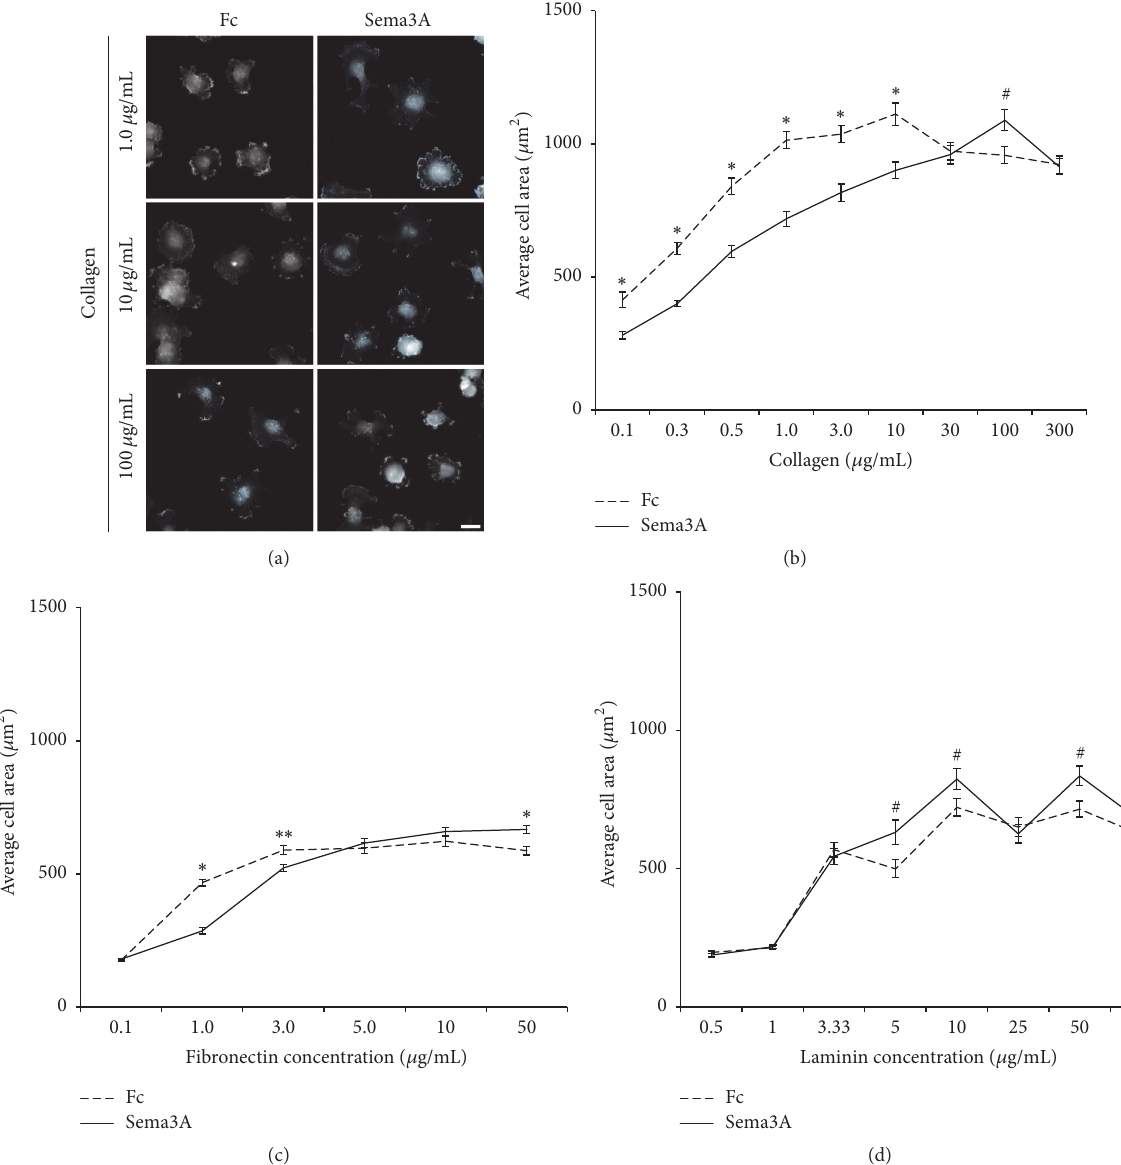
Figure 3: Sema3A increases cell spreading on low and intermediate coating concentrations of collagen and fibronectin but inhibits spreading athighcoatingconcentrationsofcollagenandfibronectin. (a)Representativeimagesofcellsattachedtosubstratacoatedwithlow(1.0 𝜇 g/mL), intermediate (10 𝜇 g/mL), and high (100 𝜇 g/mL) concentrations of collagen that were stained using TRITC-phalloidin. Scale bar = 20 𝜇 m. Average area of cells exposed to increasing substratum concentrations of collagen (b), fibronectin (c), and laminin (d). Sema3A enhanced cell spreading at lower coating concentrations of collagen and fibronectin but inhibited spreading at high coating concentrations of collagen and fibronectin. Sema3A inhibited spreading at various coating concentrations of laminin but did not have any stimulatory effect on cell spreading. Data are presented as average cell area ± SEM from a minimum of 100 cells for each condition. ∗ 𝑝 < 0.001 , ∗∗ 𝑝 < 0.005 , and # 𝑝 < 0.05 indicate statistical significance relative to IgG1 Fc control; two-sample 𝑡